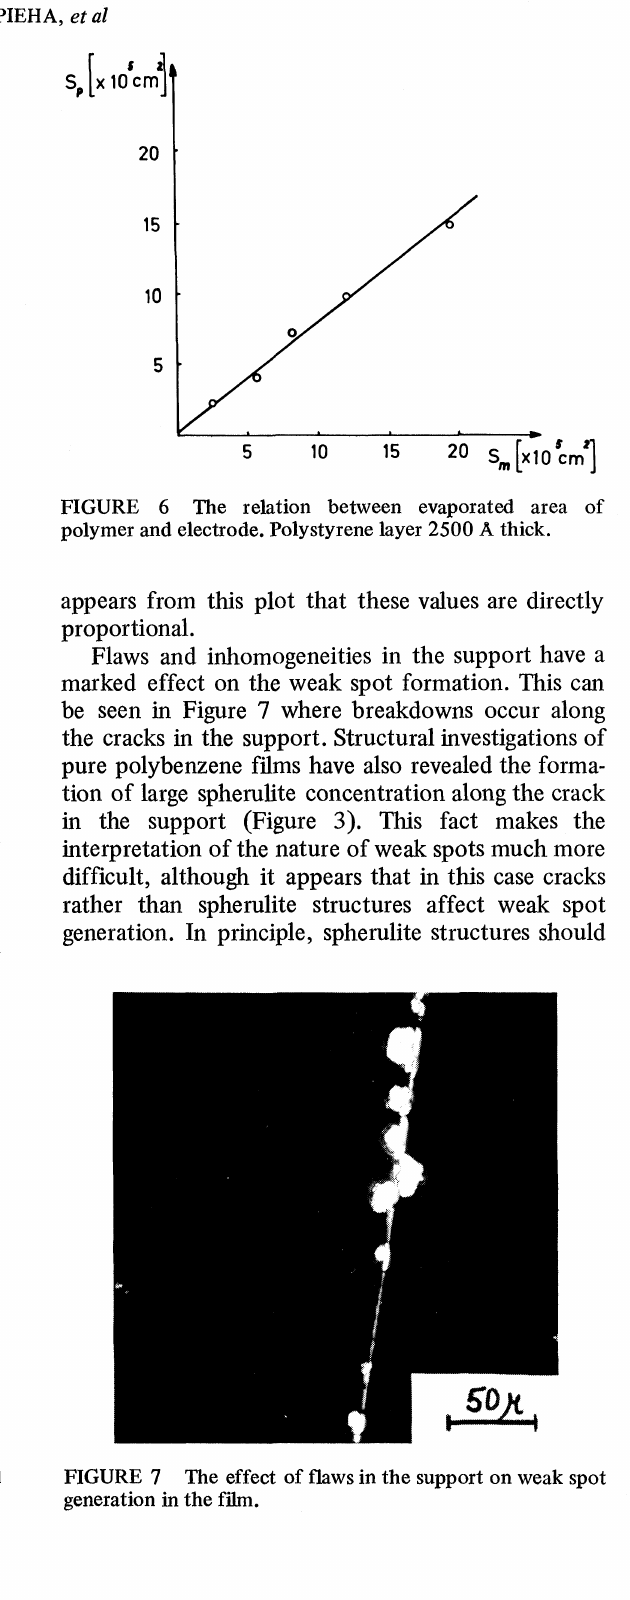
FIGURE 7 The effect of flaws in the support on weak spot generation in the